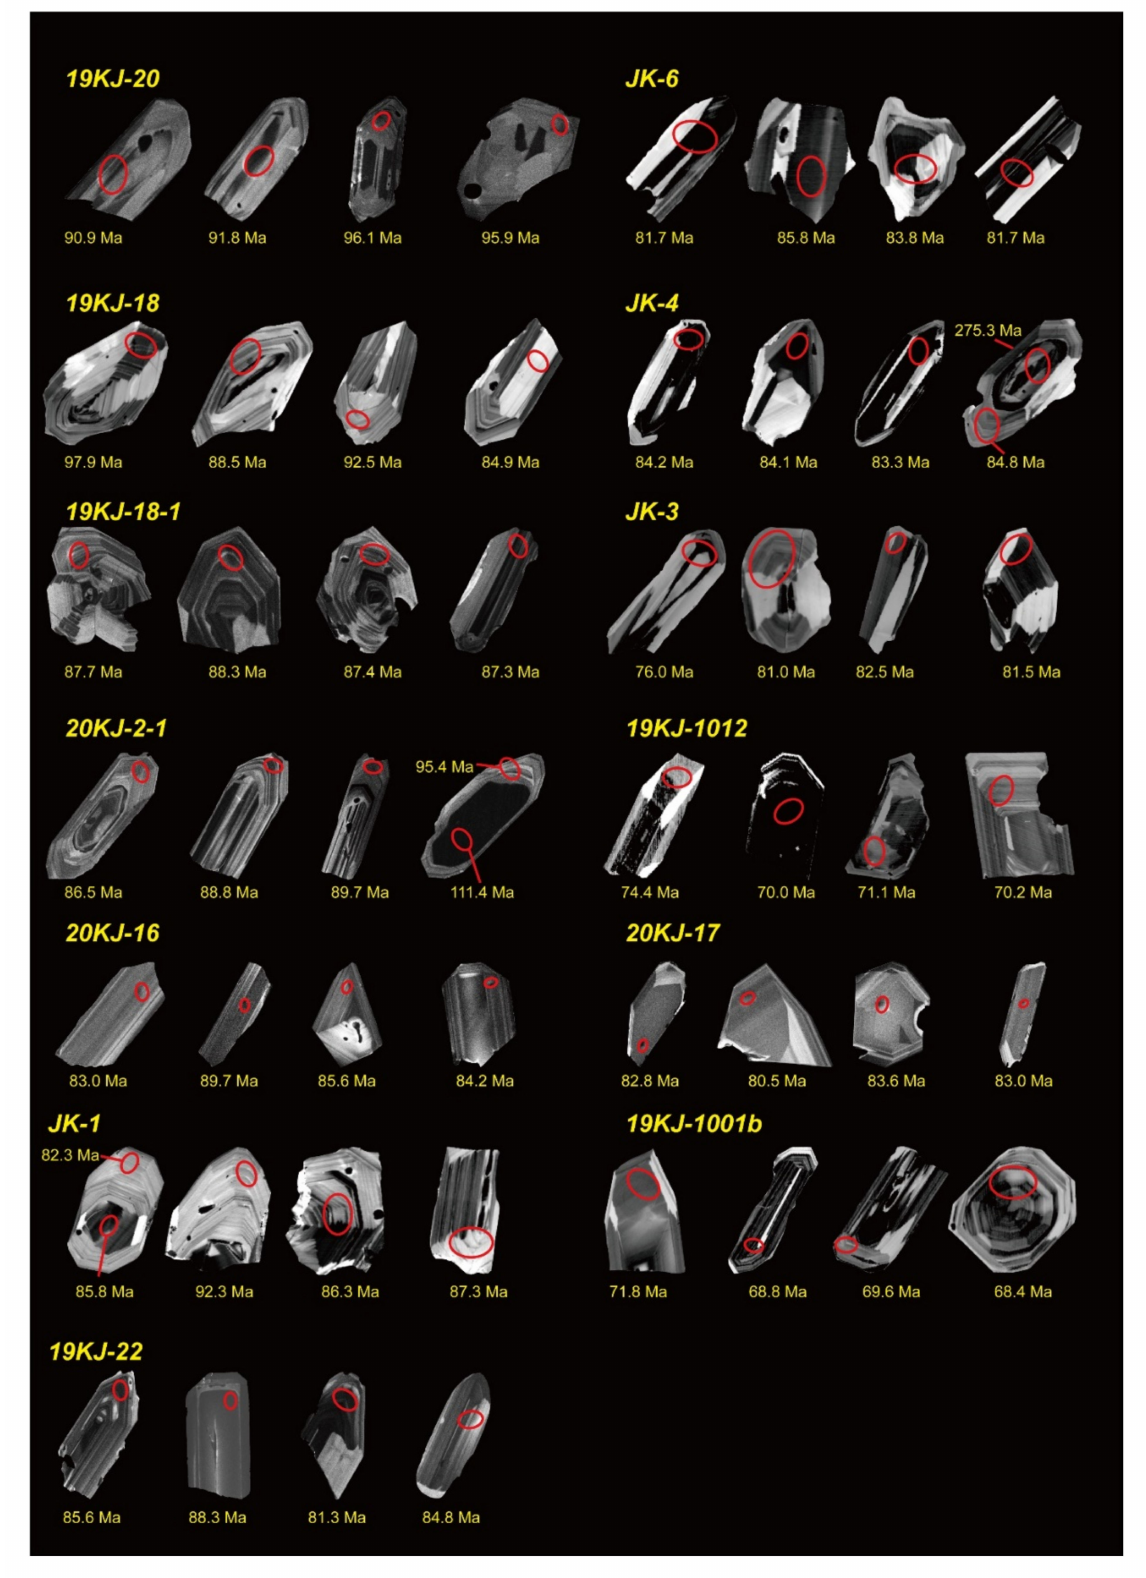
Figure 19. Representative CL images of the analyzed zircons. Red ellipses are analyzed points; their lengths are 30 µ m. The numbers are 207 Pb corrected 206 Pb/ 238 U